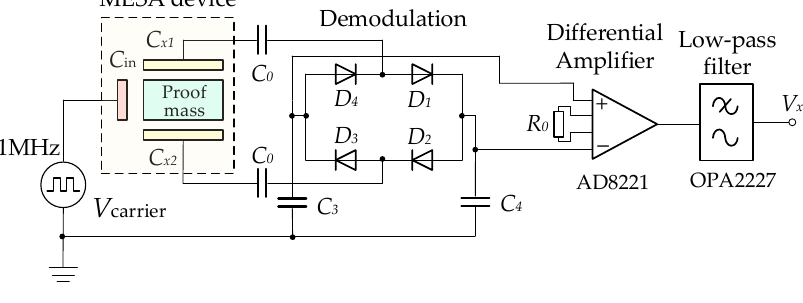
Figure 2. Schematic of the capacitive position sensing circuit.